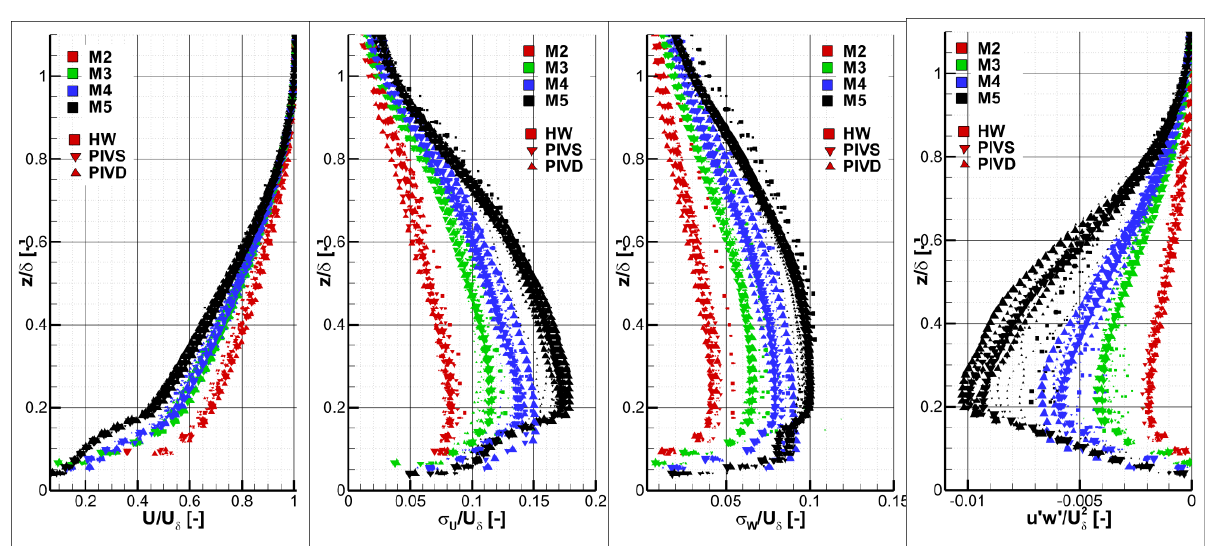
Fig. 2. Vertical profiles of mean wind speed U , stream-wise velocity fluctuations σ u , wall-normal velocity fluctuations σ u , and turbulent shear stress u’w’ . Symbol’s colour gives the setup, symbol’s shape gives the measurement method, and symbol’s size is given by the free stream